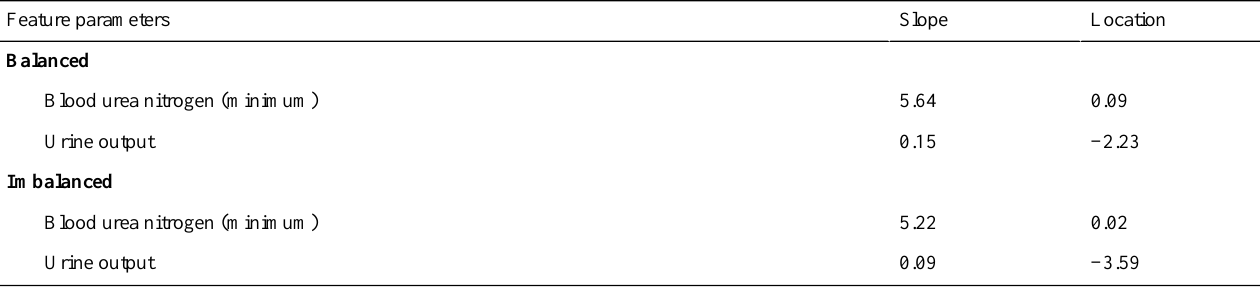
Table 4. Medical Information Mart for Intensive Care III feature parameters.